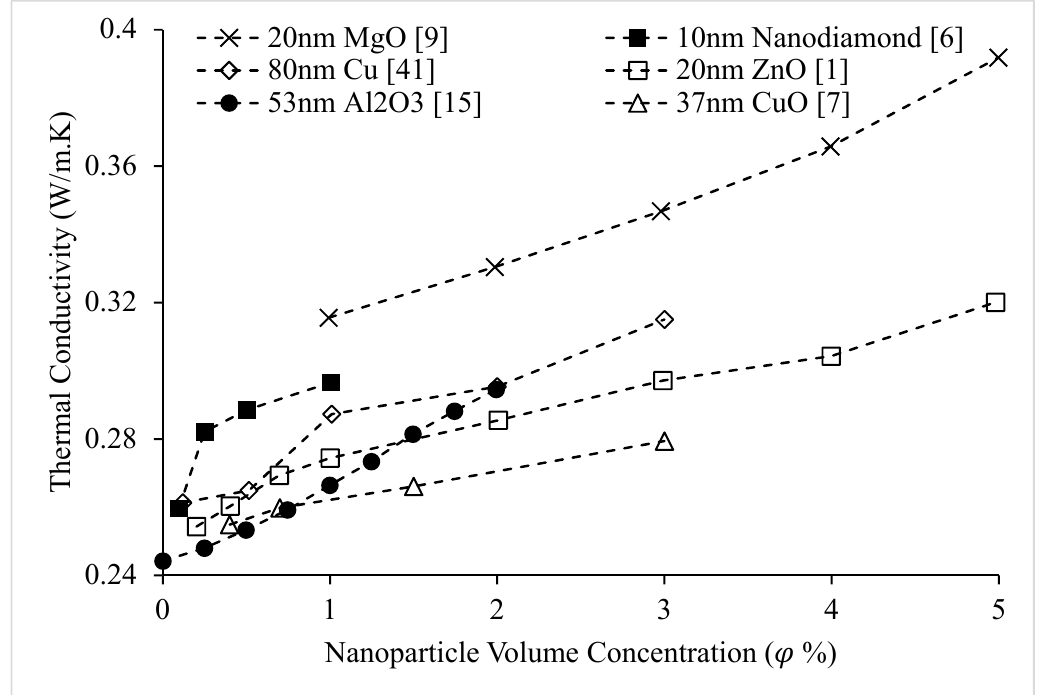
Figure 6. Variation of Ethylene Glycol-based nanofluid thermal conductivity as a function of nanoparticle volume concentration, 𝜑 , for different nanoparticles at room temperature.